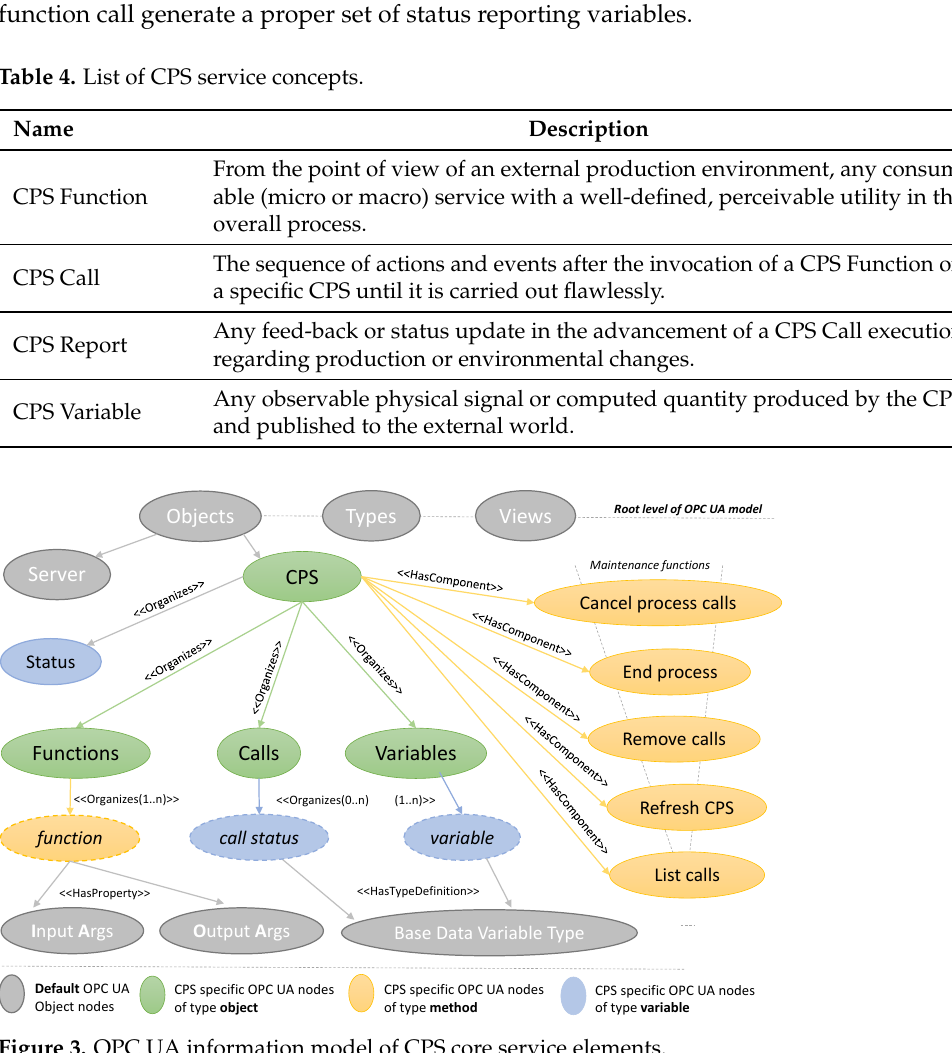
Figure 3. OPC UA information model of CPS core service